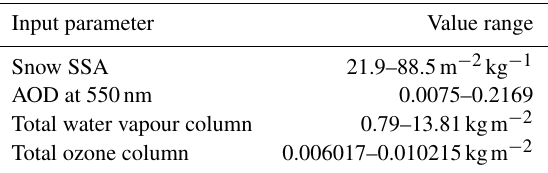
Table 4. Range of values used to evaluate the sensitivity of the TOA simulations to the model input